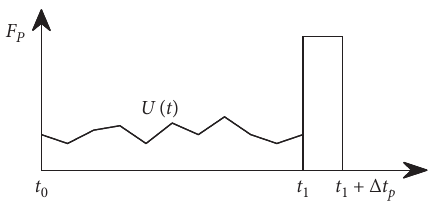
Figure 5: Thruster equivalent impulse approximation of the control force